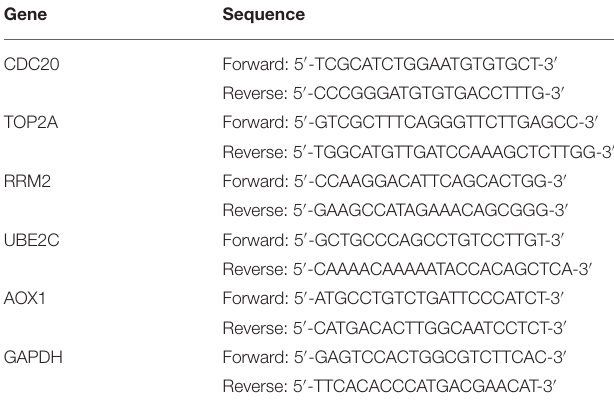
TABLE 2 | Sequences for